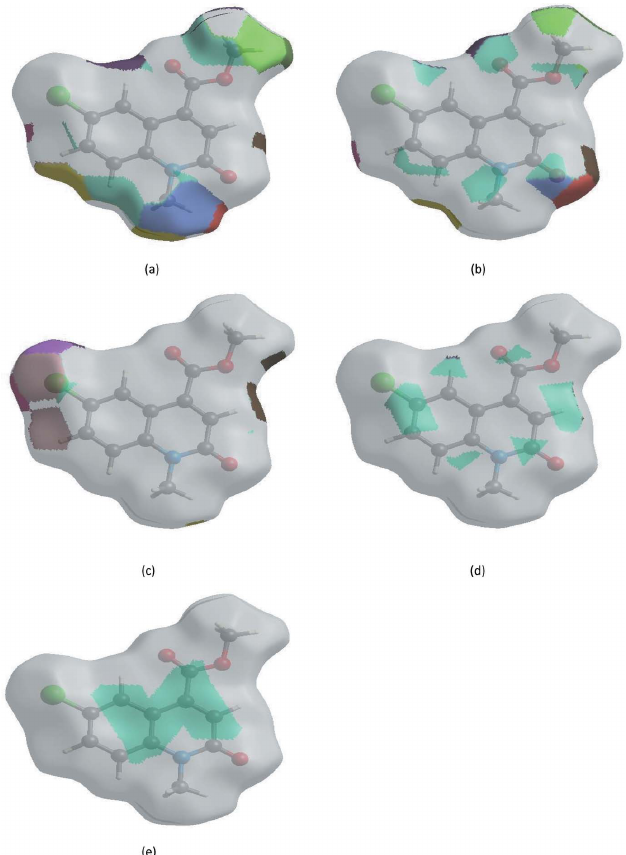
Figure 6 Hirshfeld surface representations with the function d norm plotted onto the surface for ( a ) H (cid:3)(cid:3)(cid:3) H, ( b ) H (cid:3)(cid:3)(cid:3) O/O (cid:3)(cid:3)(cid:3) H, ( c ) H (cid:3)(cid:3)(cid:3) Cl/Cl (cid:3)(cid:3)(cid:3) H, ( d ) H (cid:3)(cid:3)(cid:3) C/ C (cid:3)(cid:3)(cid:3) H and ( e ) C (cid:3)(cid:3)(cid:3) C